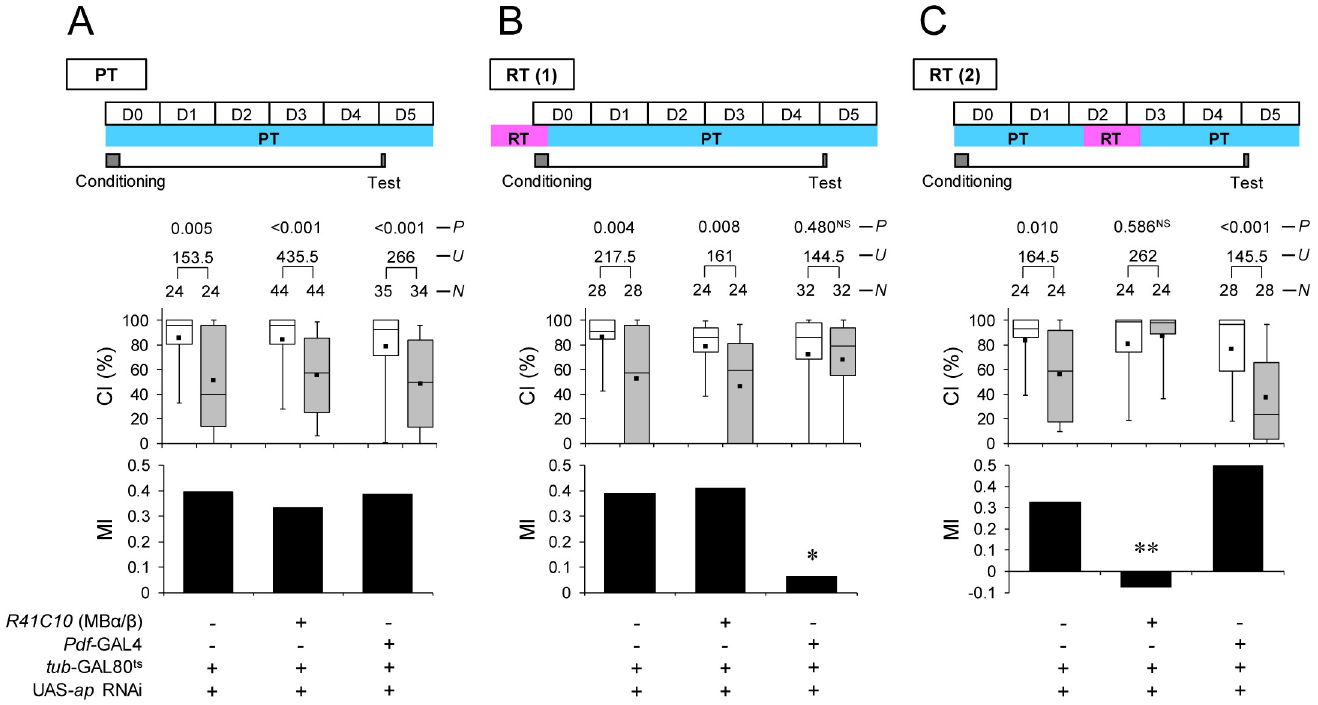
Fig 3. Temporary ap knockdown in MB α / β or Pdf neurons induces LTM impairment. (A) All experiments were performed at PT (25˚C). (B) Flies were kept at RT for 24 hours before the end of conditioning. (C) Flies were kept at RT for 48 to 72 hours after 7-hour conditioning. (A–C) Memory on day 5 in UAS- ap RNAi/+; tub -GAL80 ts / R41C10 and control (UAS- ap RNAi/ tub -GAL80 ts ) flies. Box plots for a set of CI data show fifth, 25th, 75th, and 95th centiles. In the box plots, the black square in each box indicates the mean, the line in each box is drawn at the median, the white boxes indicate naive males, and the gray boxes indicate conditioned males. The underlying data can be found in S1 Data. CI, courtship index; MI, memory index; N , sample size; U , Mann–Whitney U ; P , probability; � , P < 0.05; �� , P < 0.01; NS, not significant. Ap, Apterous; LTM, long-term memory; MB, mushroom body; Pdf, pigment dispersing factor; PT, permissive temperature; RNAi, RNA interference; RT, restrictive temperature.